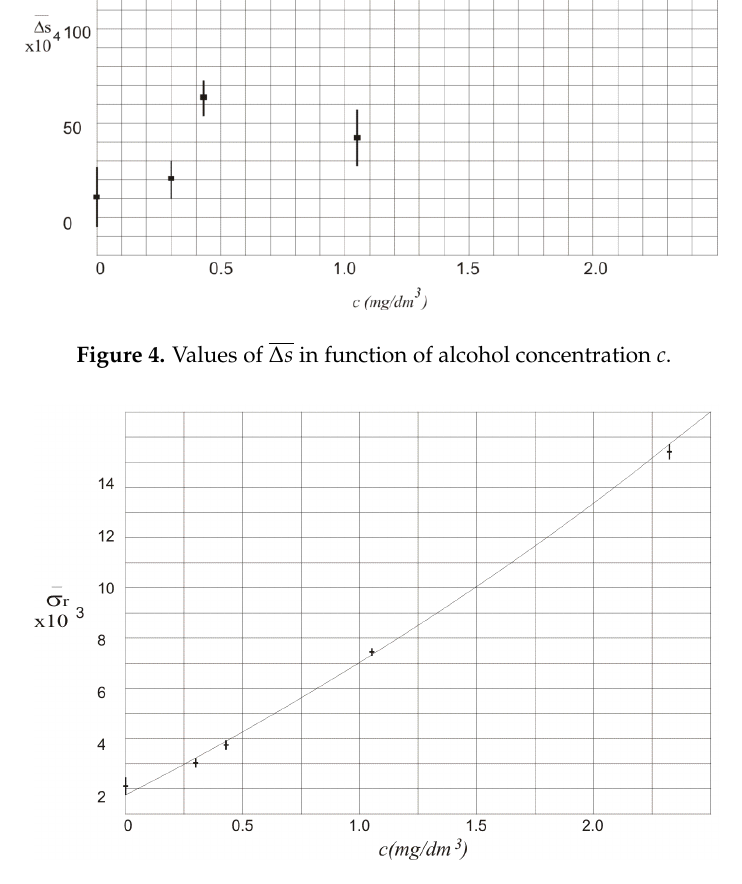
Figure 5. Values of 𝜎 𝑟 ̅̅̅ in function of alcohol concentration c . Table 3. Results of the investigation and calculation based on Equation (14).